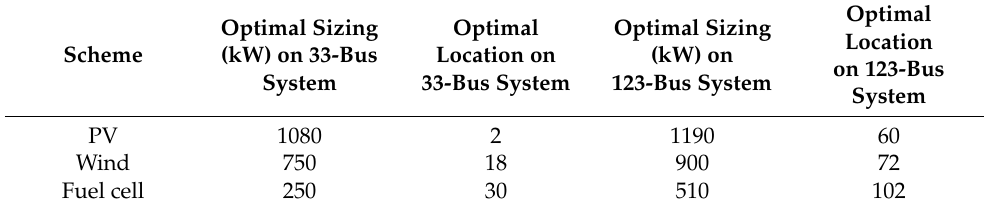
Figure 18. VRP index reduction in the IEEE 123-bus system. Table 12. Optimal placement and sizing of